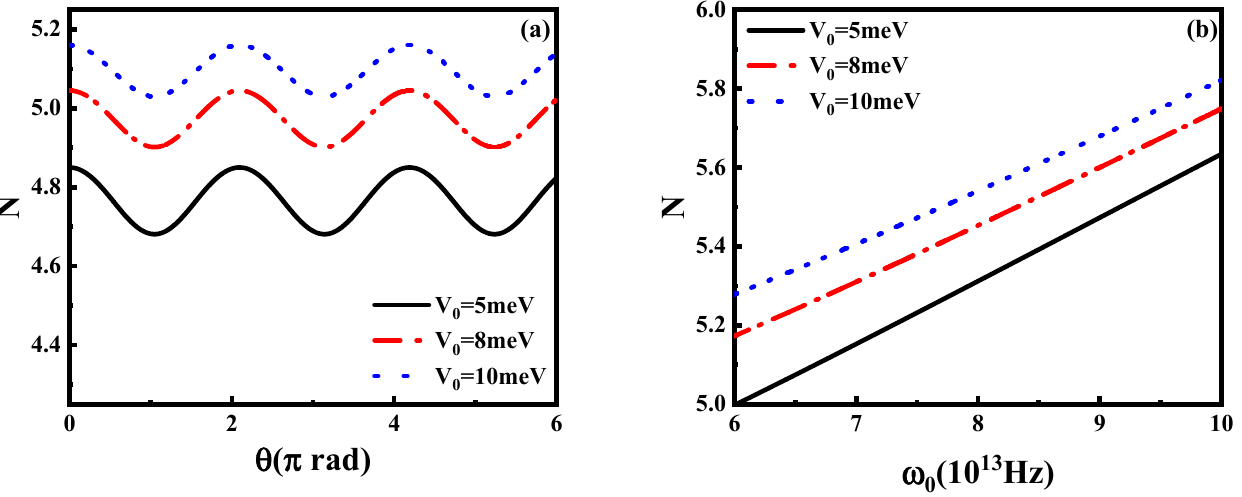
Figure 7. Vibrational frequency λ versus ( a ) polar angle θ and ( b ) confinement strength ω 0 of a polar coordinate system.